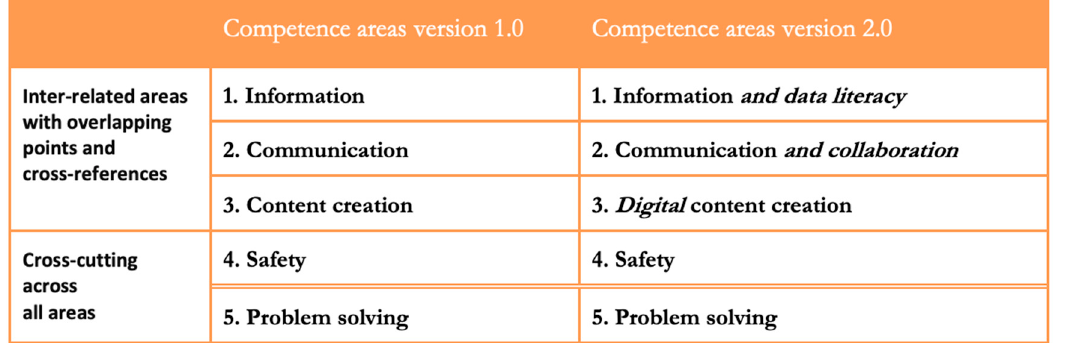
Figure 1. Competence areas version 1.0 and 2.0.